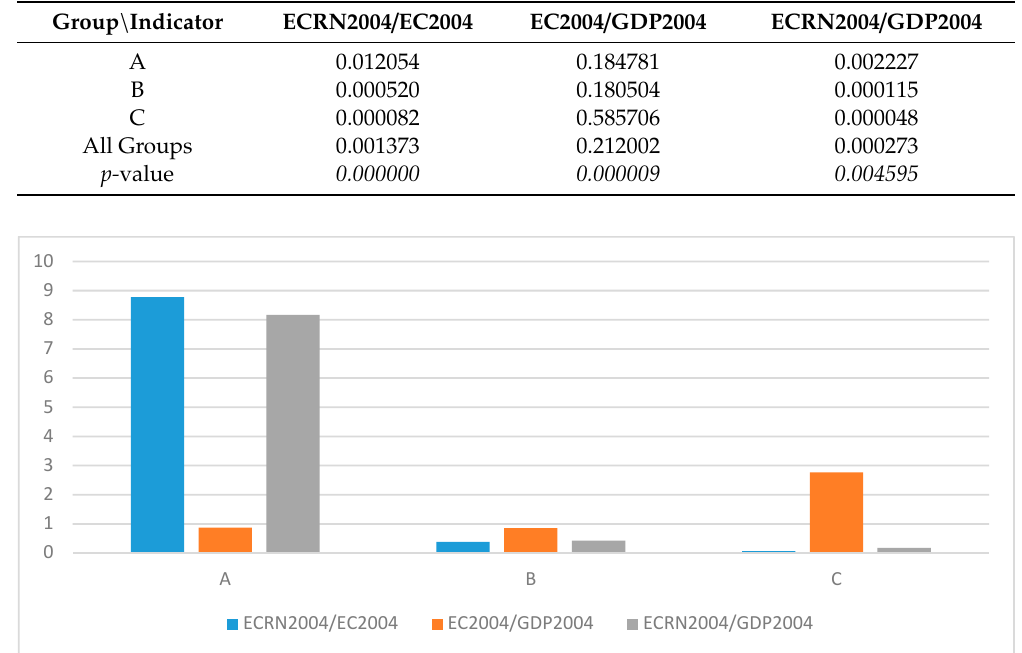
Figure 12. Comparison of group averages for IREN in 2004.